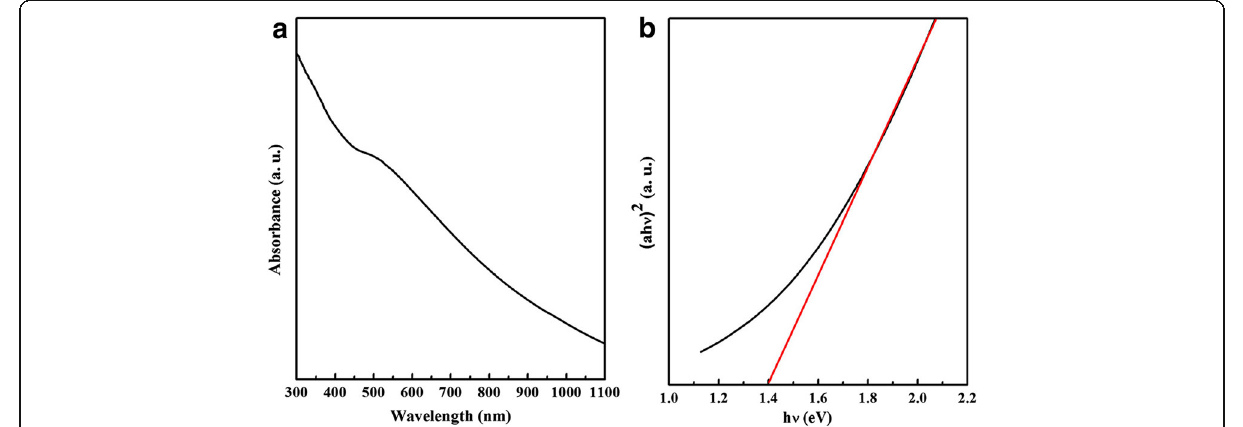
Fig. 3 a UV-vis absorption spectrum and b bandgap of CZTSe